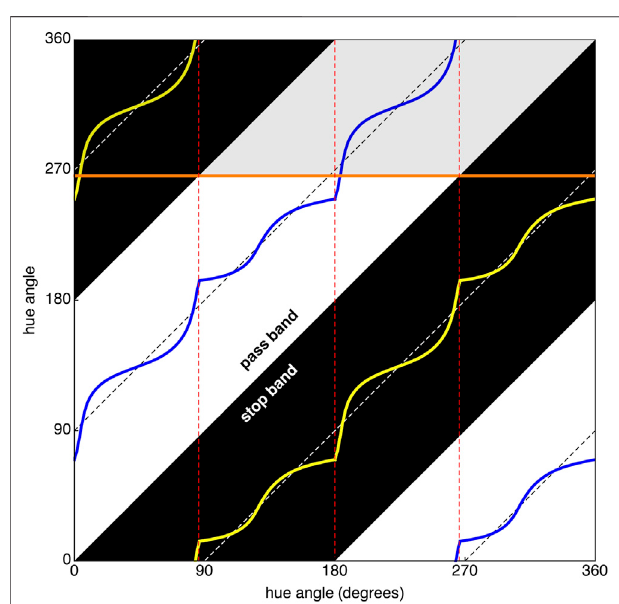
FIGURE8| Inthis “ Ostwald diagram ” Ostwald ’ sintuitioncoversonlythe dashed diagonal lines. The domain is the product of the color circle with itself, that is S 1 × S 1 (cid:2) T 2 , the torus. Thus the diagram is doubly – periodic. At top we shade an extra-spectral part. A precise computation of the full colors reveals that the oblique dashed lines suggested by the heuristic are actually intricatecurves (bluedominant wavelengths,yellowcomplementary dominant wavelengths). The original intuition remains an excellent